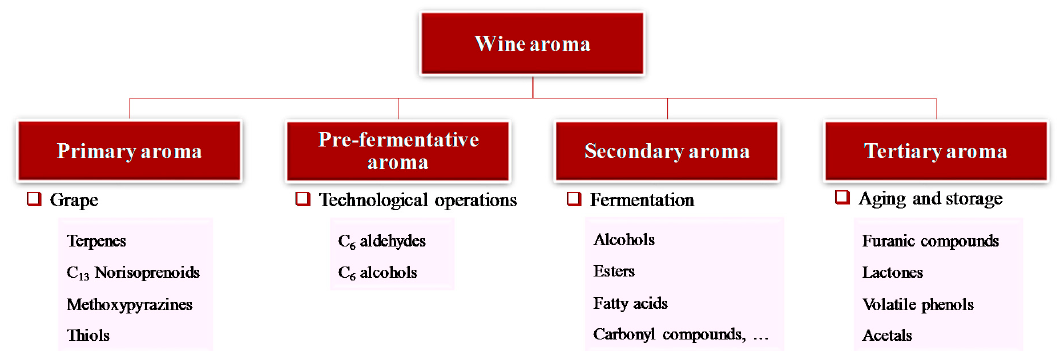
Figure 2. Classification of wine aroma according to its origin and chemical families predominant in each type of aroma.